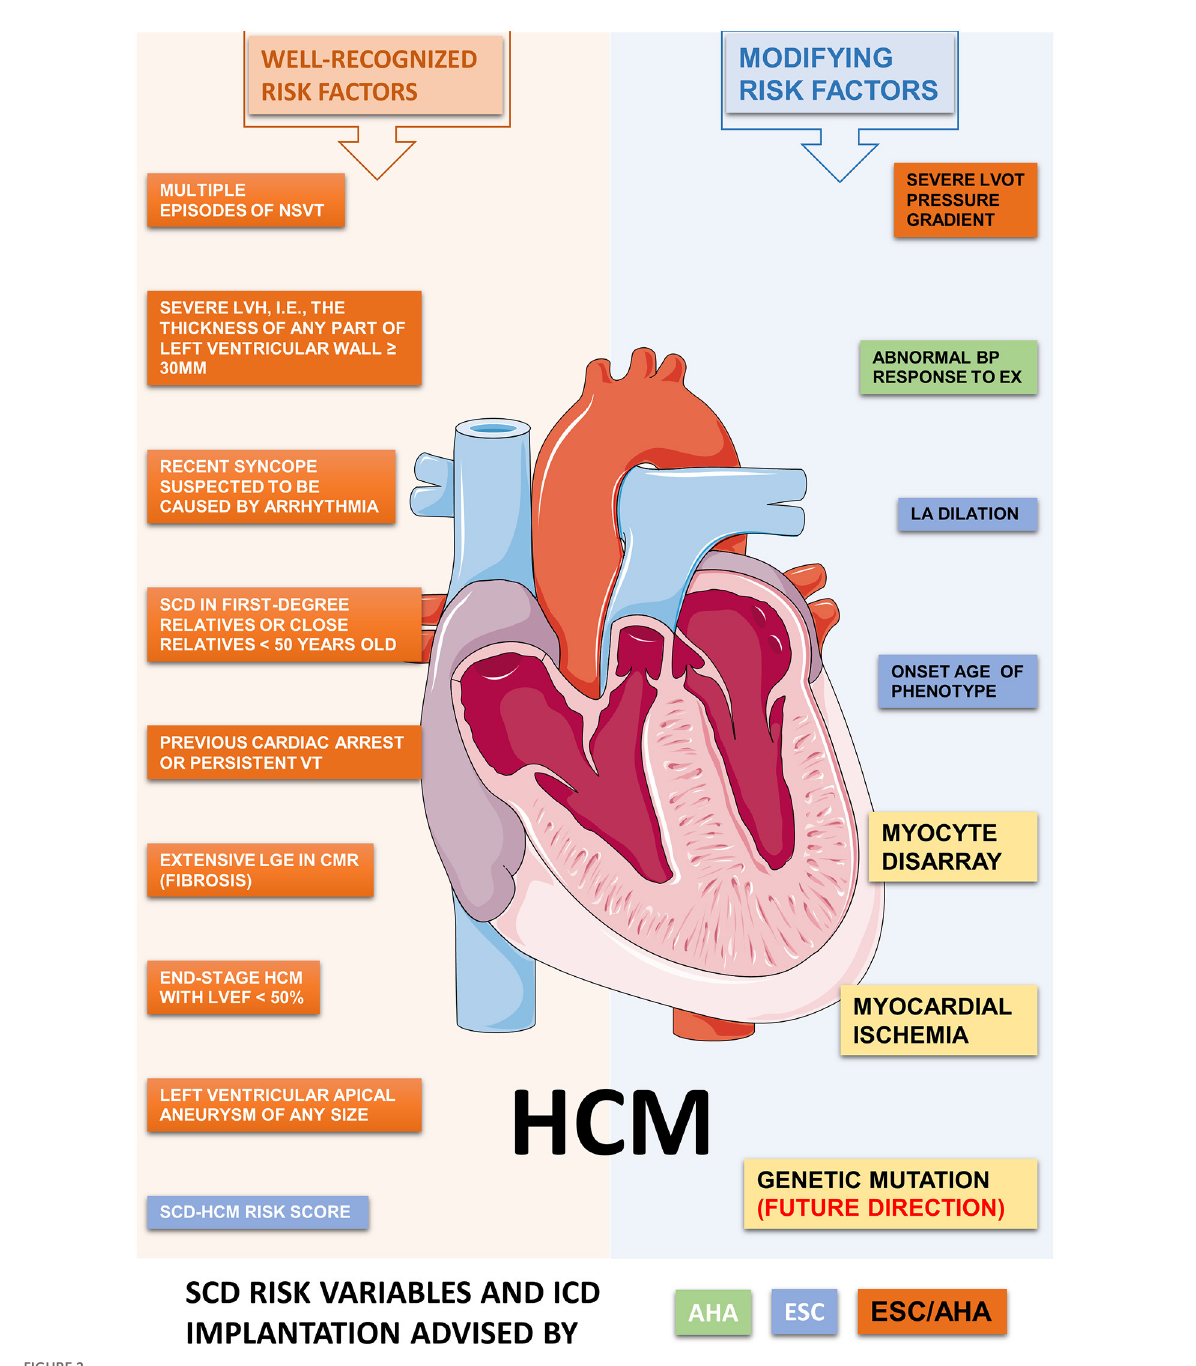
FIGURE2 Potential risk factors contributed to ventricular arrhythmia and SCD in HCM. The ACC/AHA and ESC shared a consensus on the recommendations for ICD implantation in HCM at 2003. However, major differences have aroused recently on the SCD risk classification and indications for ICD implantation. We summarize the well-recognized and some modifying risk factors related to SCD in HCM, as recommended by ACC/AHA and/or ESC guidelines. Abbreviations: HCM, hypertrophic cardiomyopathy; VT, ventricular tachycardia; ICD, implantable cardiac defibrillator; SCD, sudden cardiac death; LVH, left ventricular hypertrophy; NSVT, non-sustained ventricular tachycardia; BP, blood pressure; LGE, late gadolinium enhancement; LVOT, left ventricular outflow tract; LV, left ventricle; EF, ejection fraction; EX, exercise; LA, left